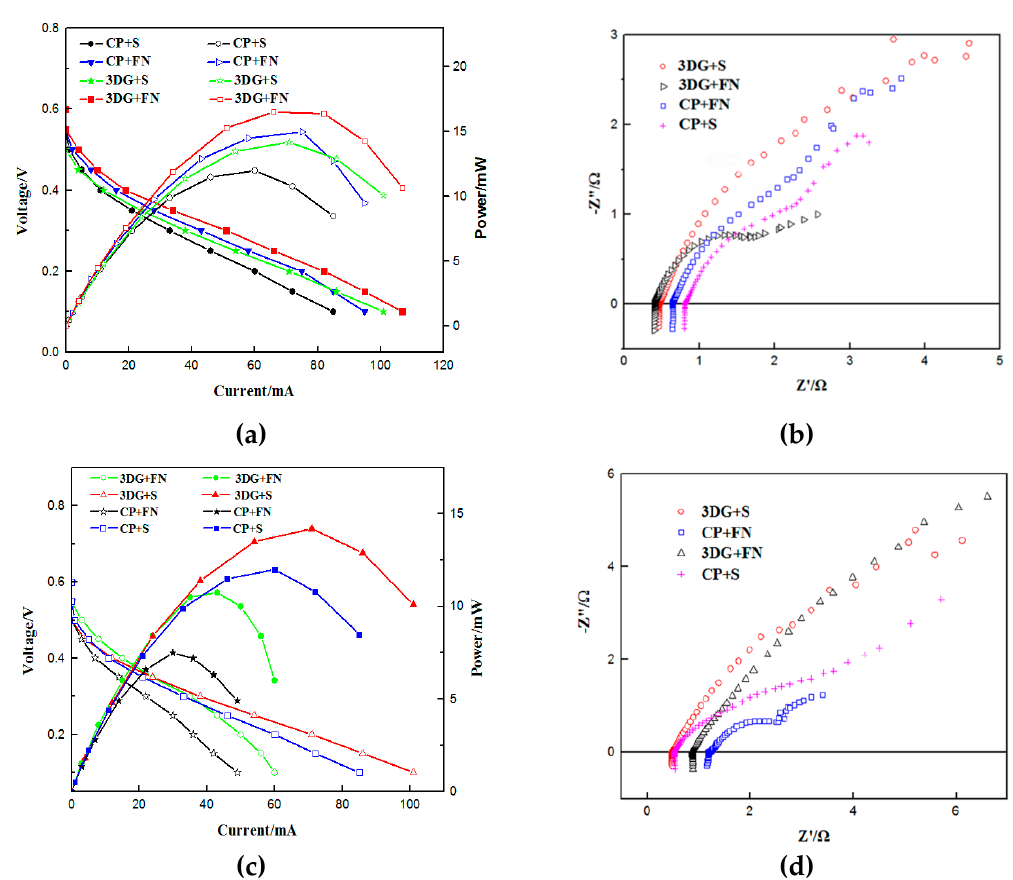
Figure 6. The polarization curve of various B- µ DMFCs before packaging ( a ) and after packaging ( c ), and the Nyquist curve of various B- µ DMFCs before packaging ( b ) and after packaging ( d ).